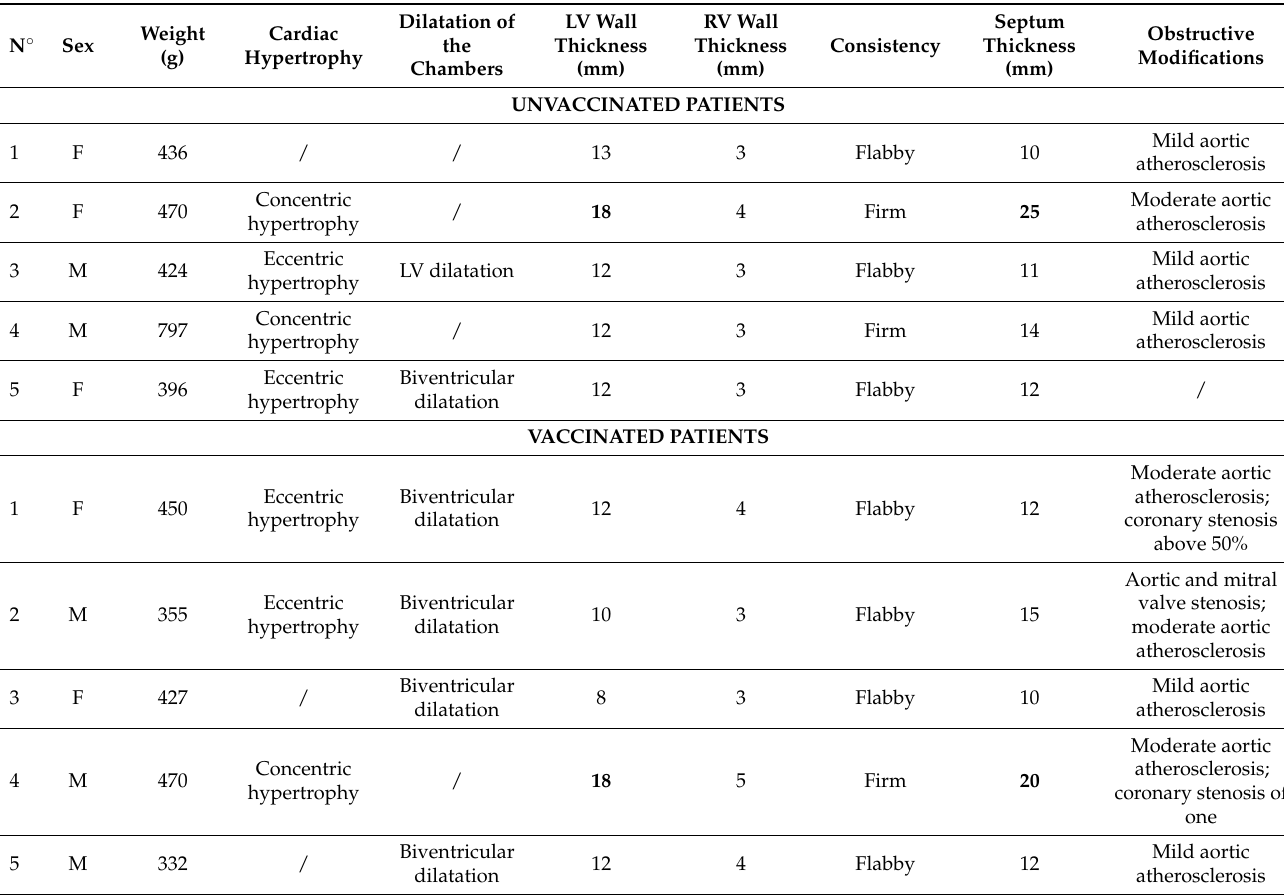
Table 5. Macroscopic heart findings.